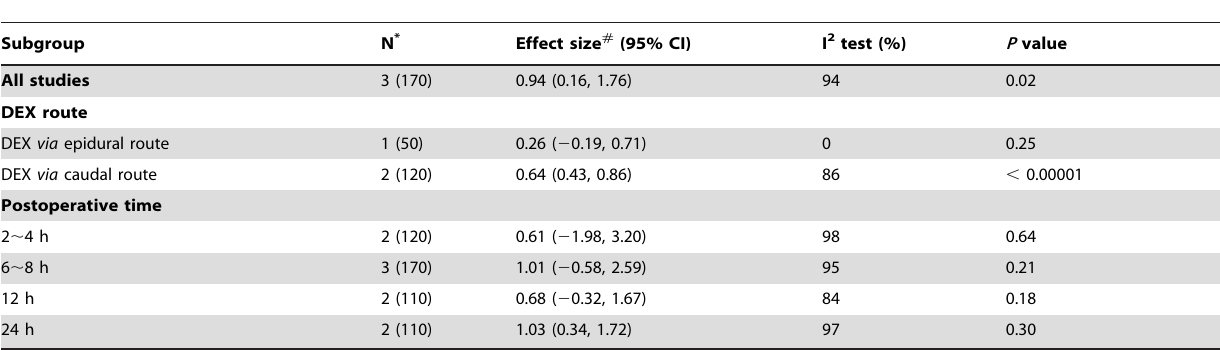
Table 2. Effect sizes and subgroup analysis of DEX on postoperative